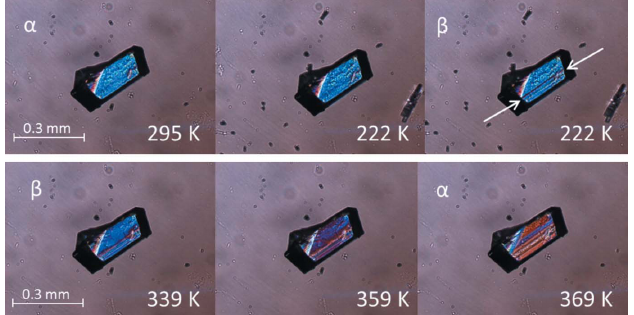
Figure 8 Thermal stage polarisation microscopy snapshots showing an example of a fast phase transition in some of the layers of a crystal; (top) the (cid:2) ! (cid:3) phase transition of dl -Nle during cooling and (bottom) the (cid:3) ! (cid:2) phase transition of dl -Nle during heating. The transforming layers are indicated by the arrows. Reprinted with permission from Smets et al. (2015). Copyright (2015) American Chemical